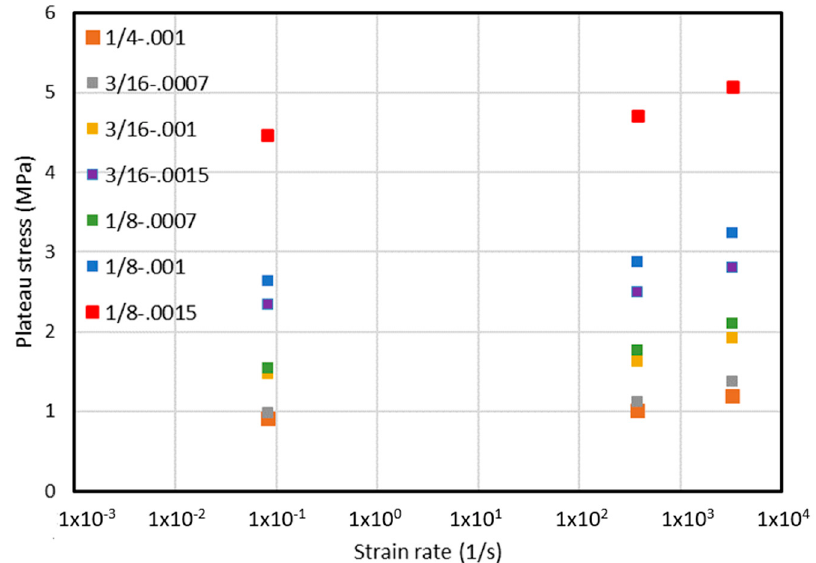
Figure 11. Values of plateau stress depending on strain rate.